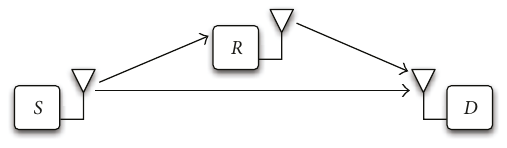
Figure 1: Nodes in basic amplify and forward